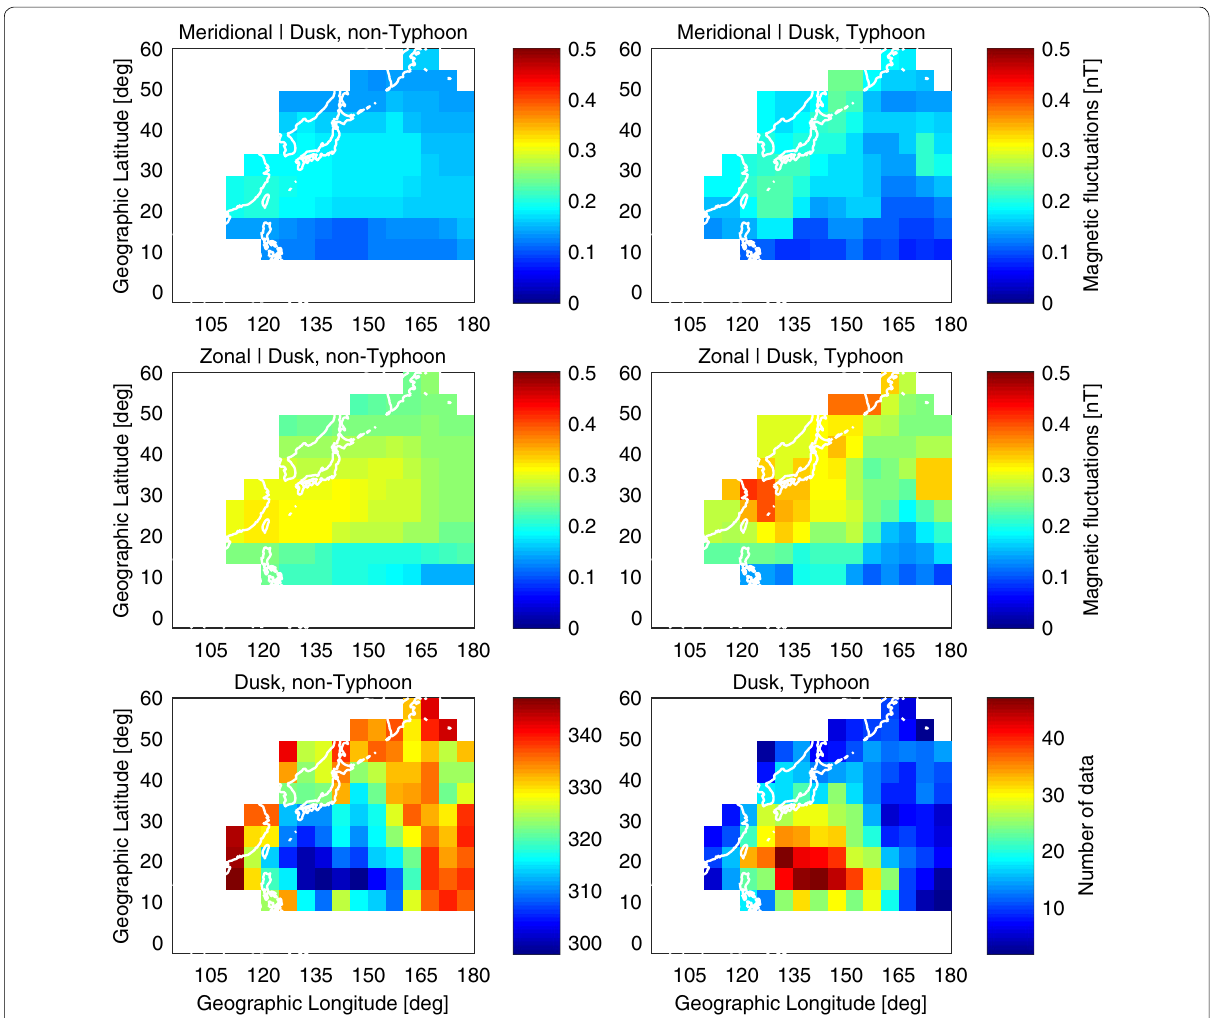
Fig. 12 zMR amplitudes between typhoon and non-typhoon cases. The left and right panels show non-typhoon and typhoon cases on the dusk side sector (15–21 LT), respectively. Average amplitudes of the meridional ( top ) and zonal ( middle ) components, and number of data ( bottom ) in each mesh grid are